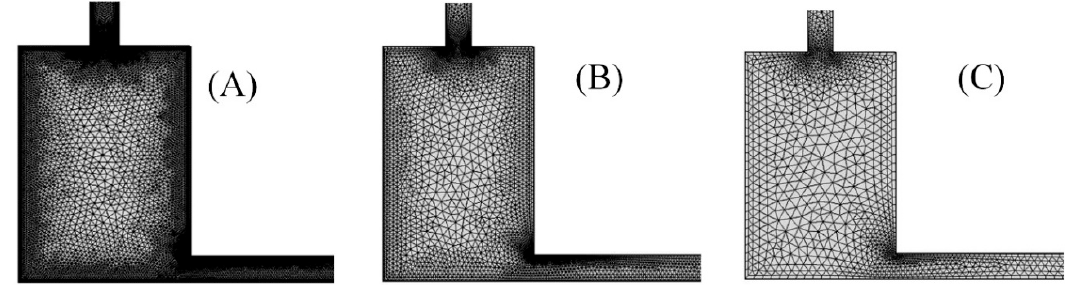
Figure 3. Domain mesh: ( A ) Extremely fine: 130,311 domain elements and 8233 boundary elements, ( B ) Extra fine: 41,757 domain elements and 4261 boundary elements, ( C ) Finer: 13,036 domain elements and 2025 boundary elements.